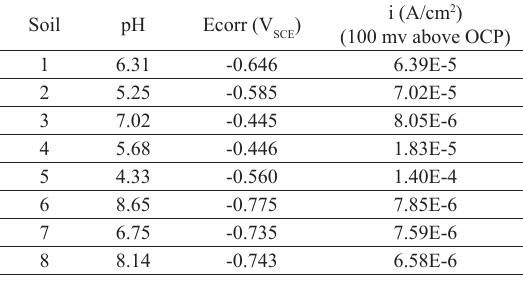
Table 5. Electrochemical parameters determined in aqueous extract of soil.